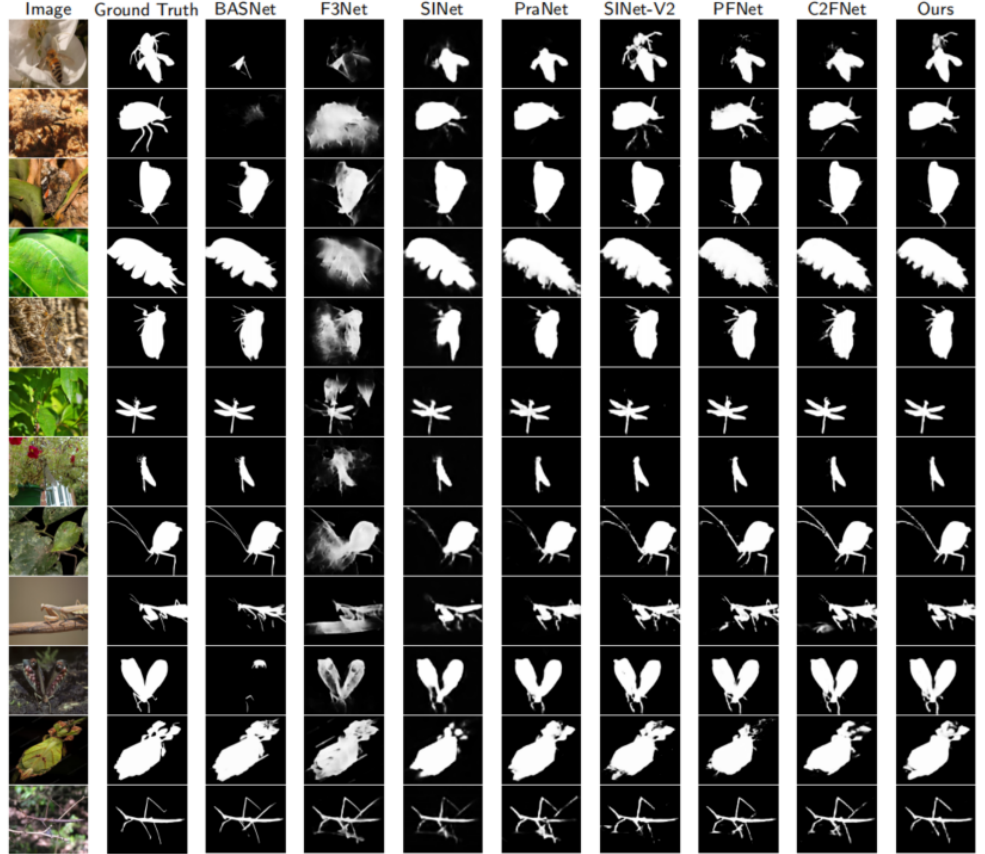
Figure 6. Visual comparison of different methods (Best viewed in